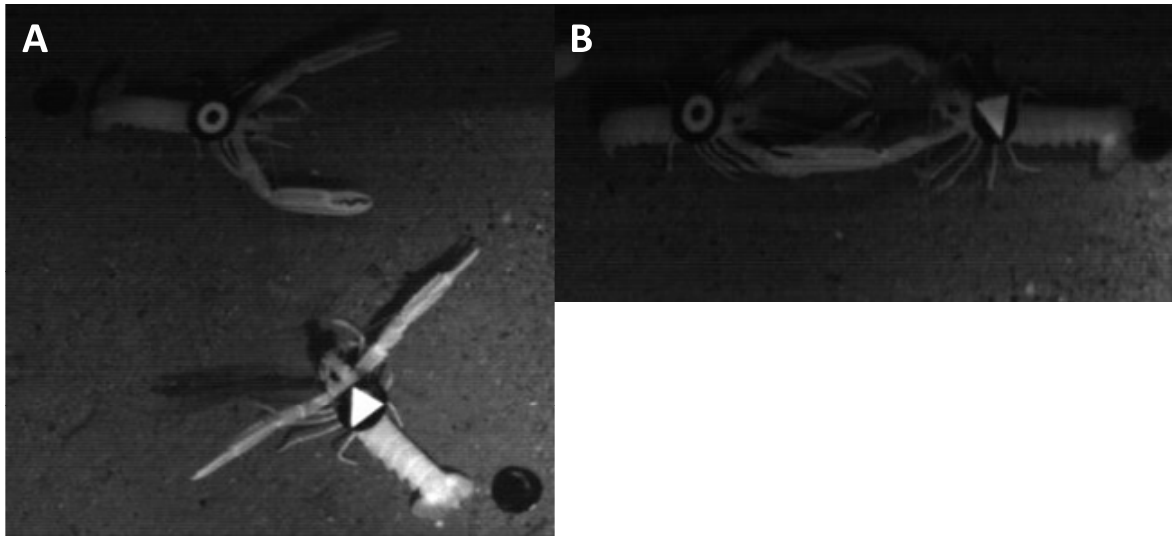
Figure 5. A photographic sequence of aggressive interactions between two individuals of Nephrops is presented as an example of the mechanism that generates burrow emergence rhythms of different strengths. The initial aggressive postures (A) during the approach of the animals are indicated by the forward maximum opening of the claws. This aggressive display is followed by a short contact confrontation (B) . The geometric tags for the automated video imaging and the dragged black RFID transponders are also